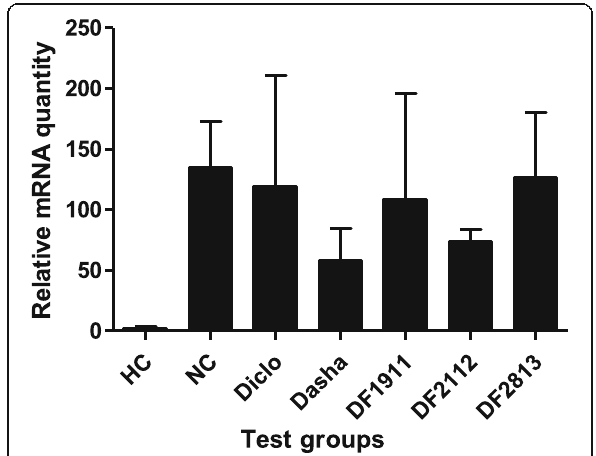
Fig. 7 Effect formulations on the mRNA expression of iNOS in inflamed paw tissue. HC: Healthy control, NC: Negative control, Diclo: Diclofenac sodium, Dasha: Dashamoola Kwatha , DF: Dashamoola Formulation. Values are expressed as Mean ± SEM ( n = 3). Comparisons were done between NC/HC and each individual treated group by Dunnett ’ s multiple comparison